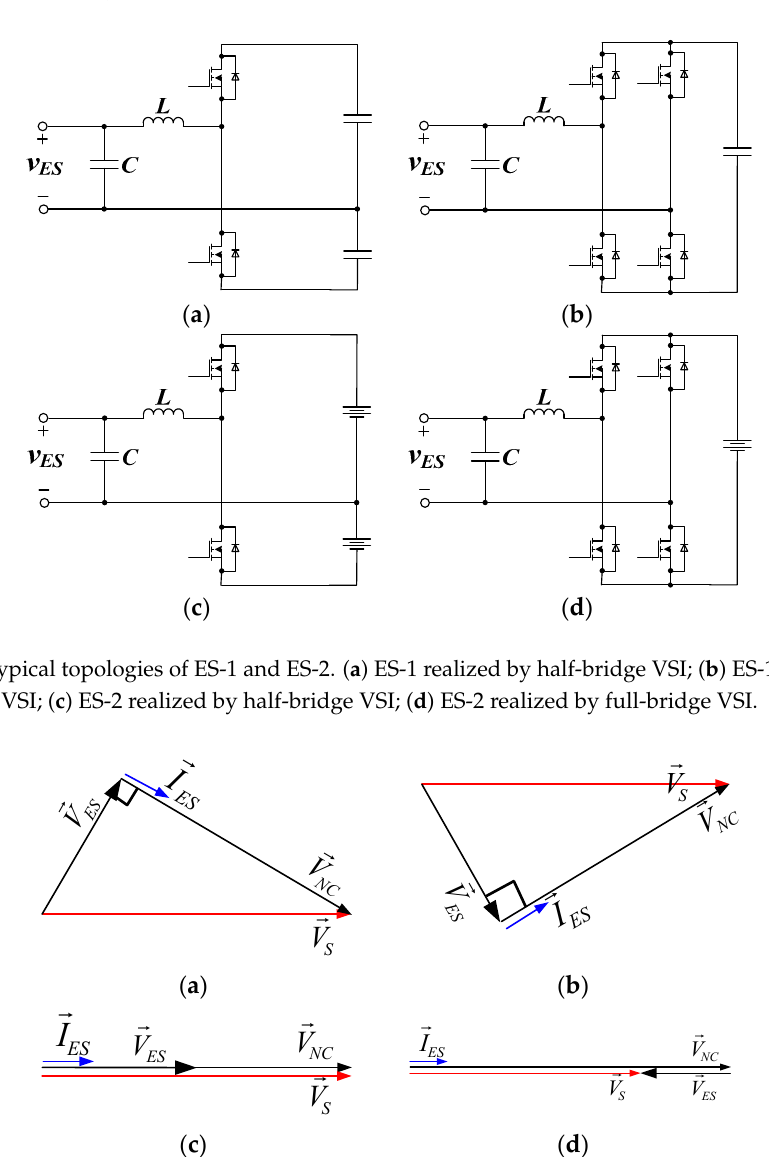
 →  I and ES I ES and I and ES